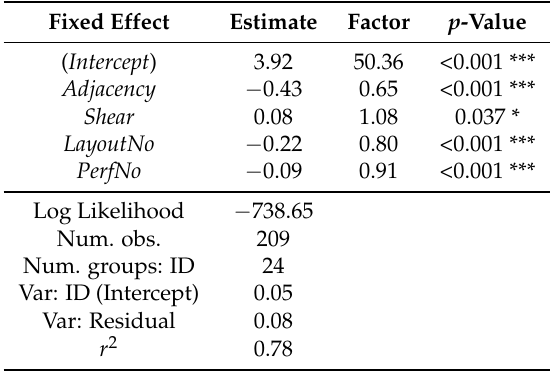
Figure 3. Inaccuracies, averaged across participants, for the arpeggio training task. The higher the line, the more accurate the average performance. The bootstrapped confidence intervals cover a 95% range. Adjacent layouts have solid lines, nonadjacent have dashed lines. Sheared layouts have orange lines, unsheared have blue lines. The first performance is coded 0, the second is coded 1, ...; the first layout is coded 0, the second is coded 1. Table 2. Generalized linear mixed effects model for the arpeggio training